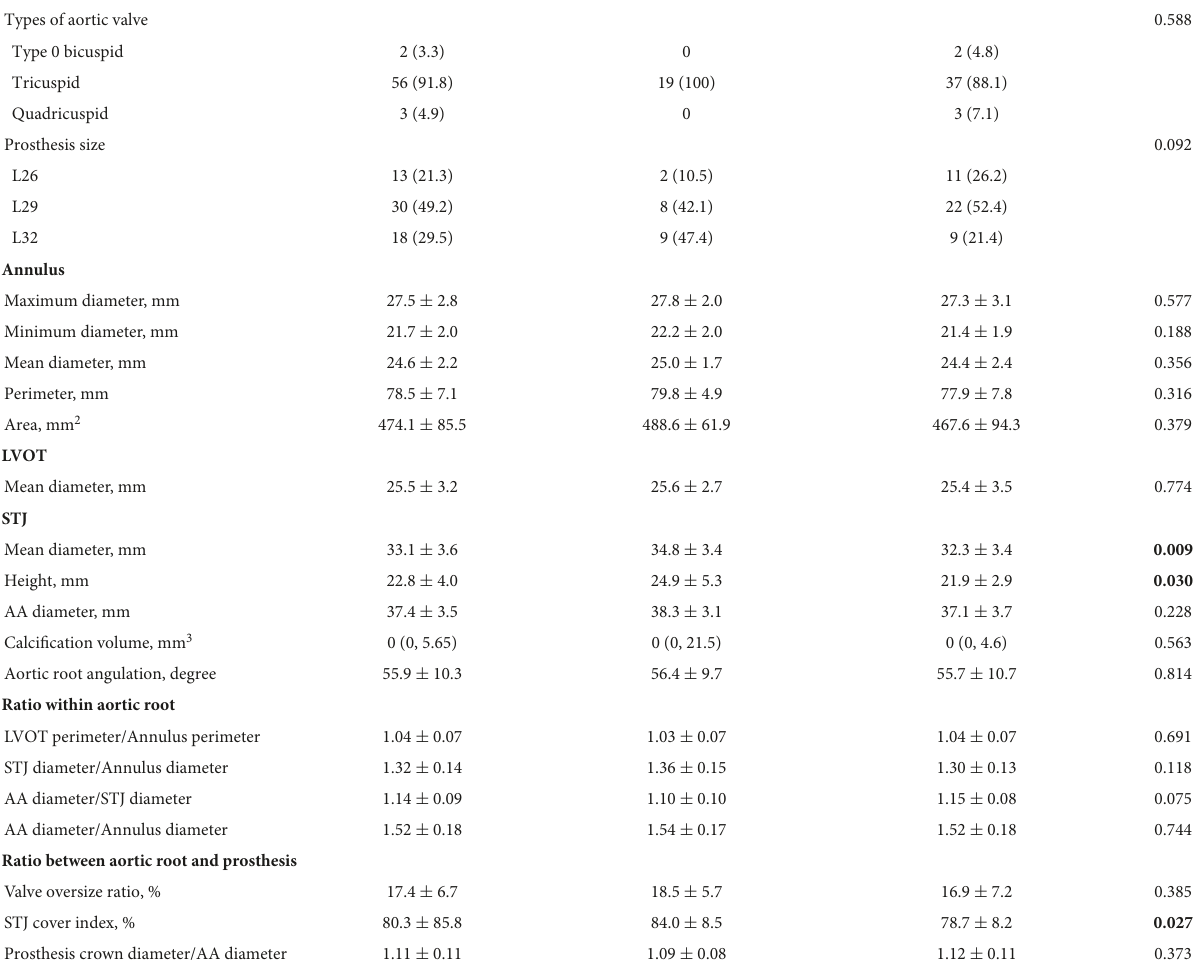
TABLE 2 Anatomic characteristics of the